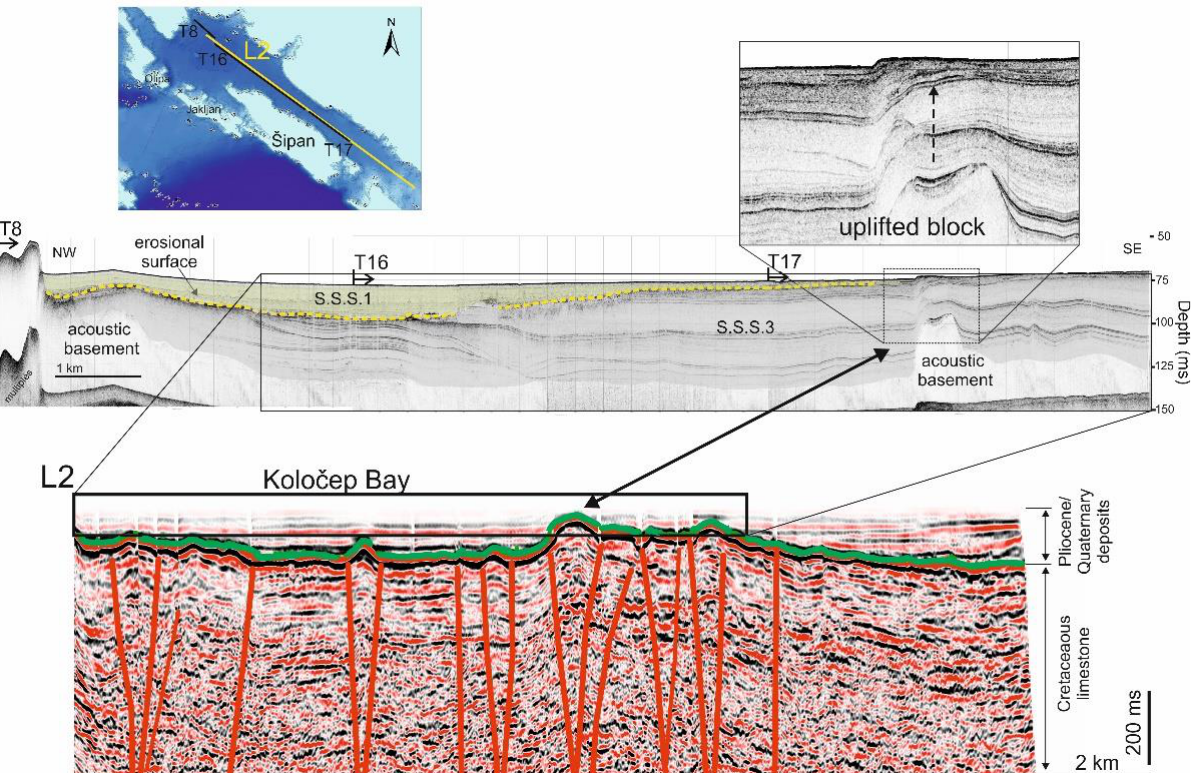
Figure 14. Two-dimensional seismic profile of L2 correlated with high-resolution seismic profiles T8, T16 and T17. On profile L2, the red vertical lines represent faults, and the green line represents the Mesozoic boundary. On profile T17, we can observe an uplifted block that uplifted Pleistocene and Holocene deposits. Due to uplift in this area, sediment sequence S.S.S.2 is completely eroded.